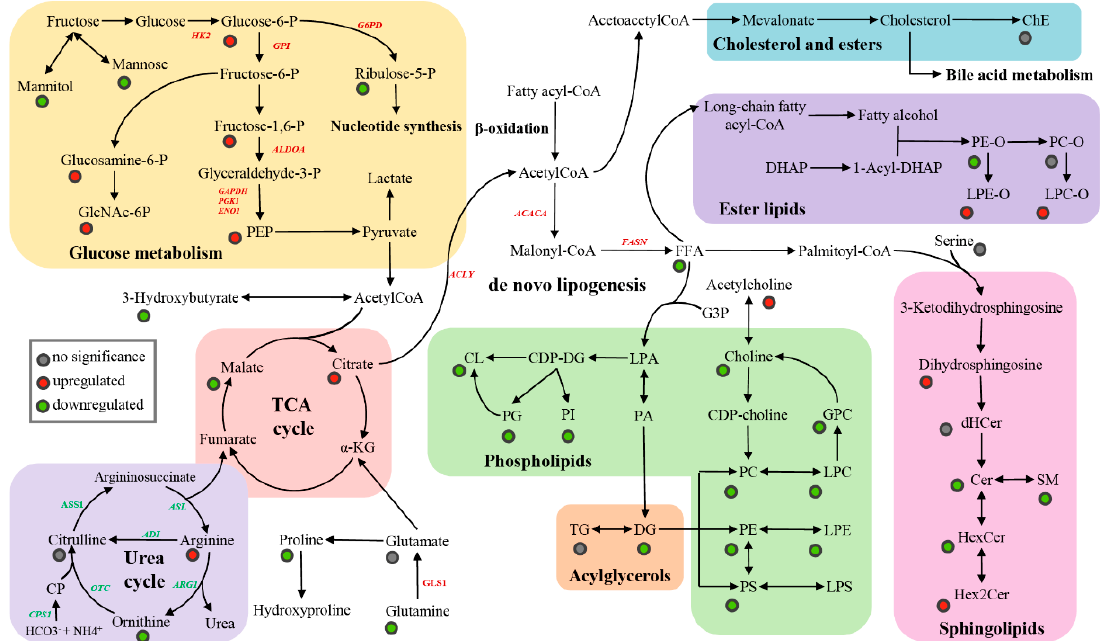
Figure 2. Overview of the lipid biosynthetic and metabolic pathways. Colored dots represent the metabolite and lipid changes in HCT samples compared to ANT samples. Note that the pathway network has been truncated due to space restrictions.